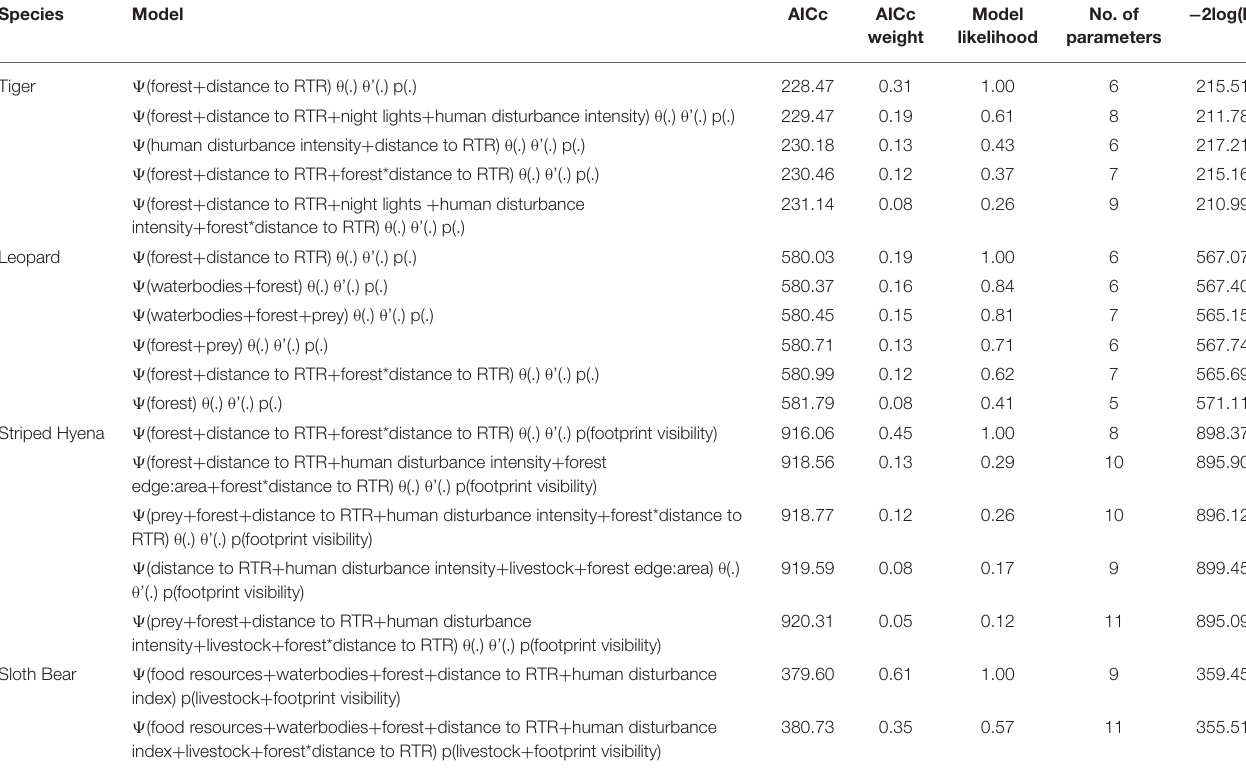
TABLE 2 | Model comparisons to determine influence of ecological and anthropogenic covariates on species’s occupancy/habitat use. Species